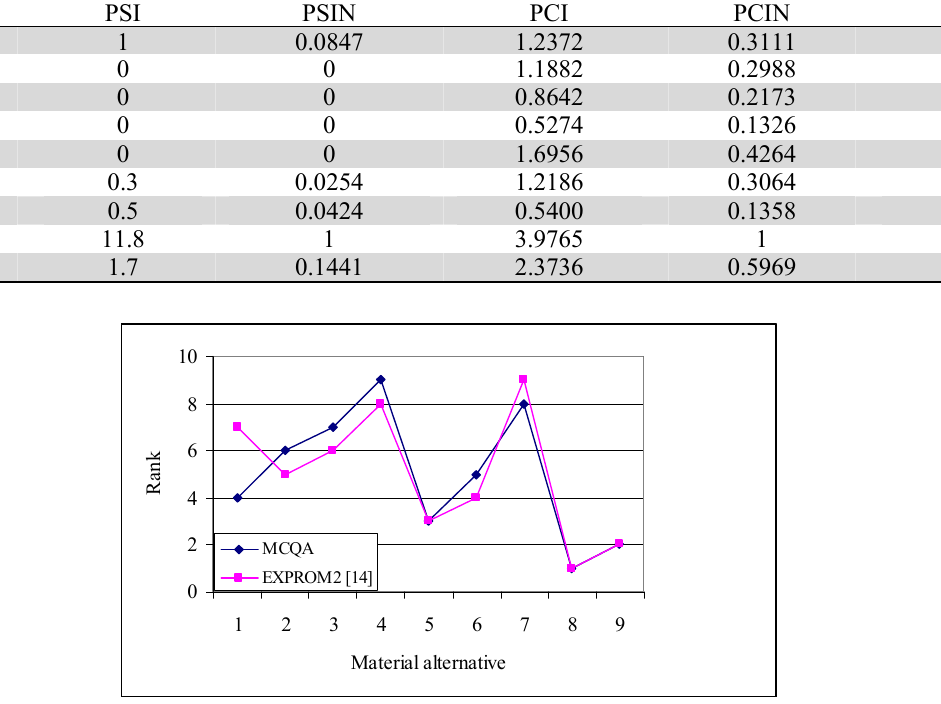
Fig. 2. Comparison of material rankings for example